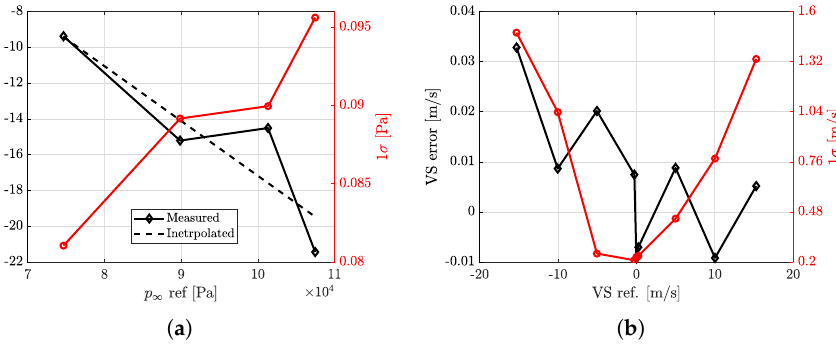
Figure 7. Altitude and vertical speed uncertainty analysis. ( a ) Static pressure, ( b ) Vertical